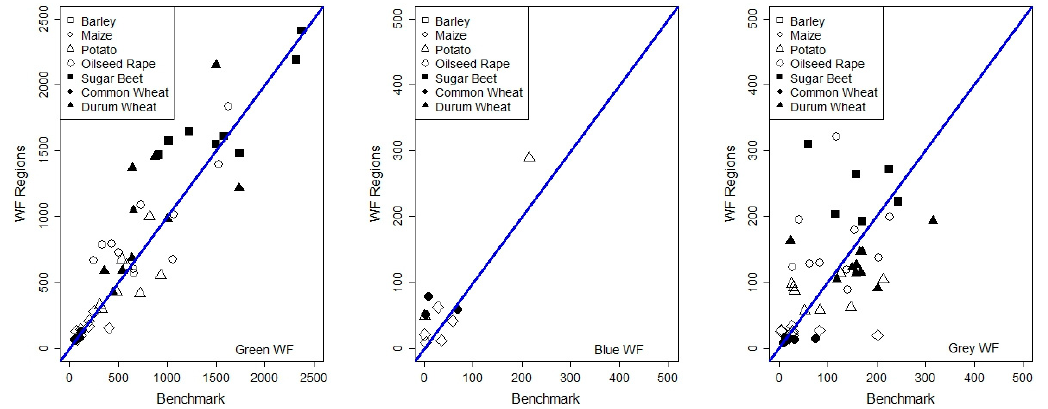
Figure 14. Comparison of green, blue and grey water footprints (WF) of this study with benchmark WF [16] in m 3 · Mg − 1 for arable crops. The blue line represents the identity line.